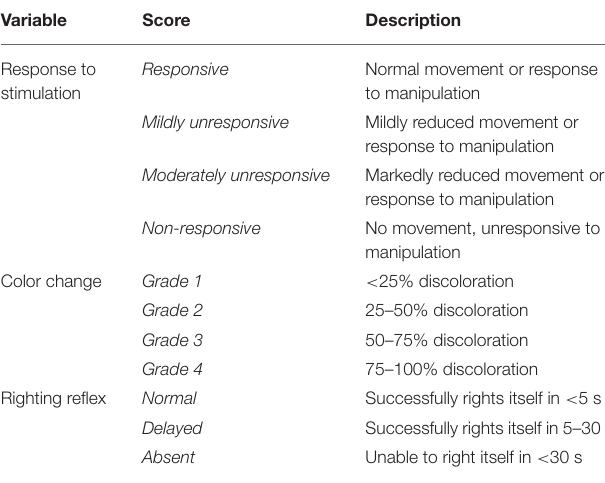
TABLE 1 | Scoring rubric for assessment of response to stimulation, color change, and righting reflex prior to and following injection with homologous